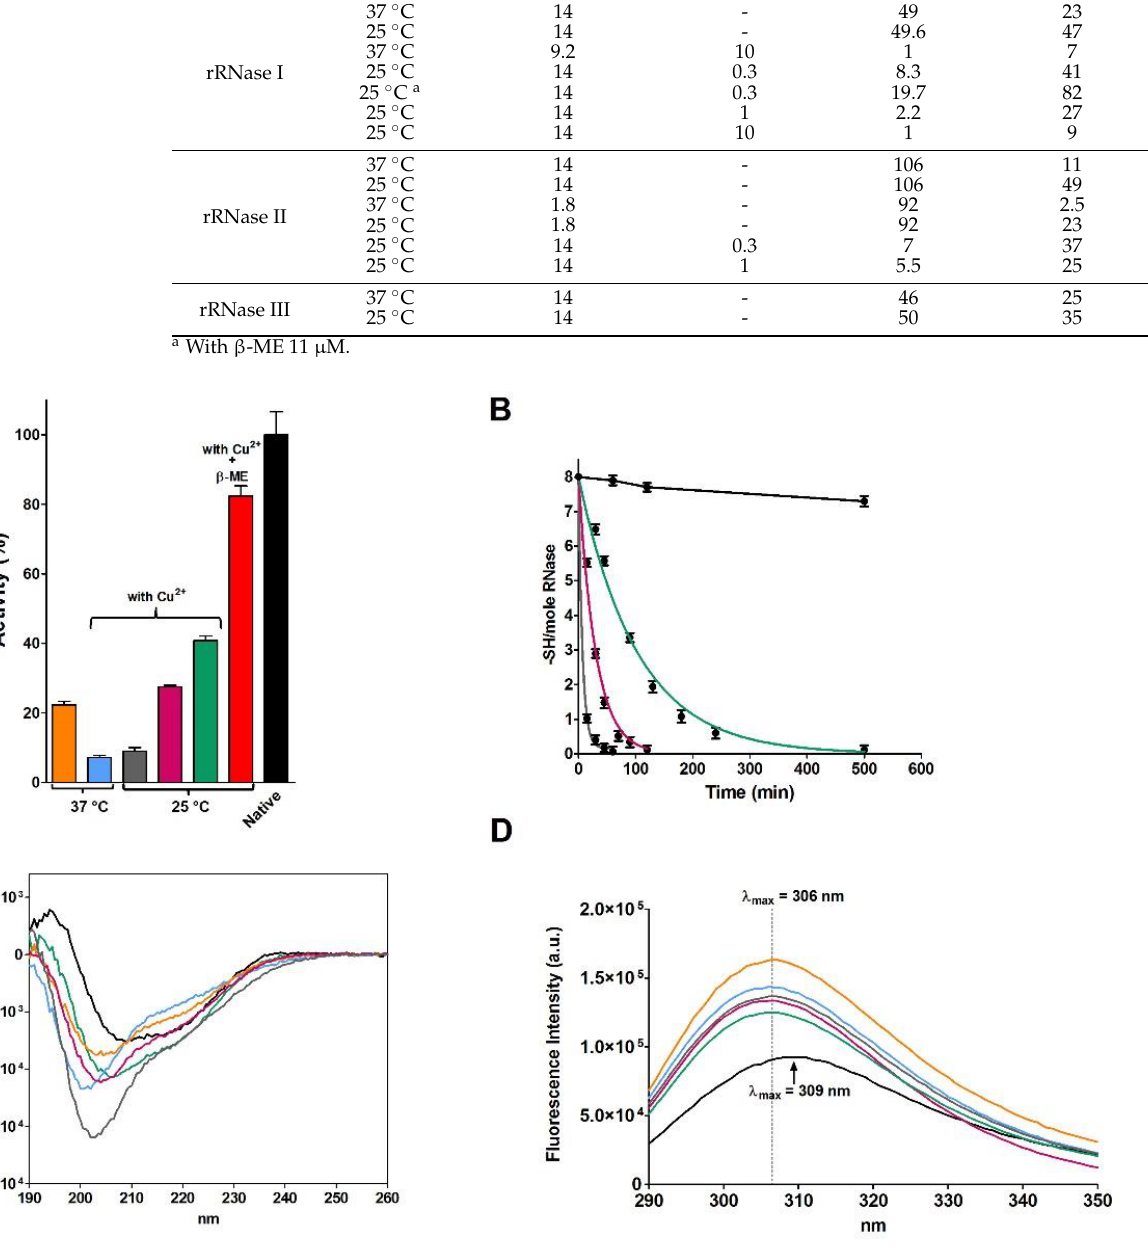
Figure 1. Re-oxidation of rRNase I (14 µ M) in 20 mM Tris-HCl pH 8.5 under different conditions. ( A ) Recovery of activity after incubation at 37 ◦ C without (orange column), or in the presence of Cu 2+ (10 µ M) (light blue column). At 25 ◦ C in presence of Cu 2+ (10 µ M) (grey column), Cu 2+ (1 µ M) (pink column), Cu 2+ (0.3 µ M) (green column), and Cu 2+ (0.3 µ M) with β -ME (11 µ M) (red column). All the activities are compared to the activity of the native protein (black column). Activities were